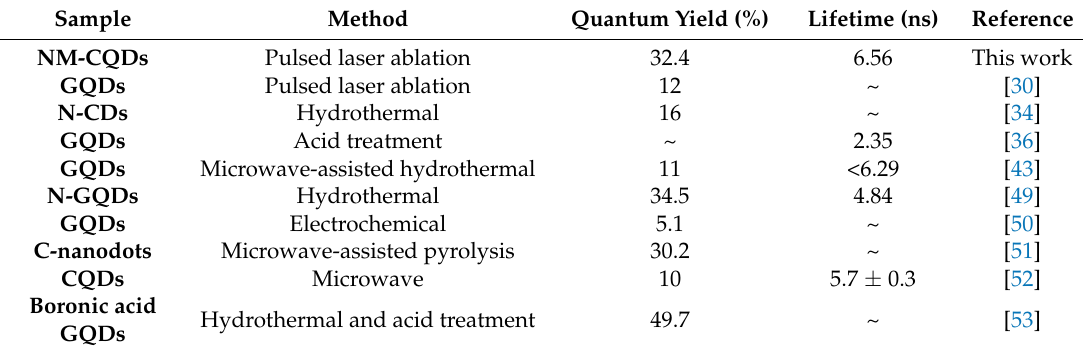
N-CDs Hydrothermal GQDs Acid treatment GQDs Microwave-assisted hydrothermal N-GQDs